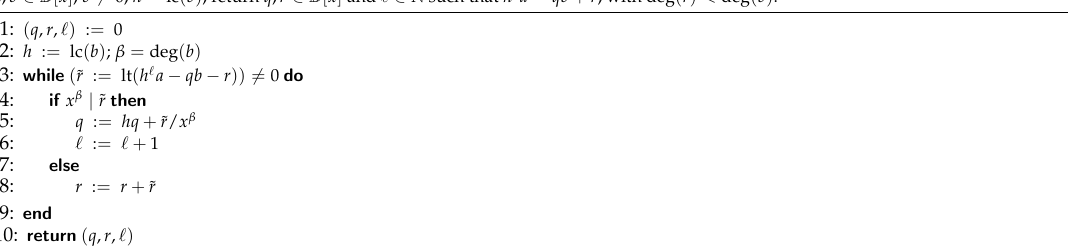
Algorithm 5 PSEUDO D IVIDE P OLYNOMIALS ( a , b ) a , b ∈ D [ x ] , b (cid:54) = 0, h = lc ( b ) ; return q , r ∈ D [ x ] and (cid:96) ∈ N such that h (cid:96) a = qb + r , with deg ( r ) < deg ( b )